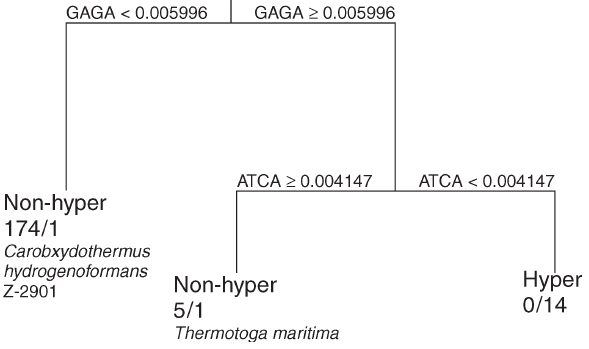
Figure 1. Classification tree of hyperthermophile (hyper) versus non- hyperthermophile (non-hyper) based on tetramer relative frequencies of 195 genomes. Each split shows the tetramer selected by CART for each level of classification and the relative frequencies for each direc- tion. Nodes show the classified temperature range and number of or- ganisms classified in each temperature category according to NCBI (non-hyper/hyper). Organisms misclassified in this model are listed under the appropriate nodes.